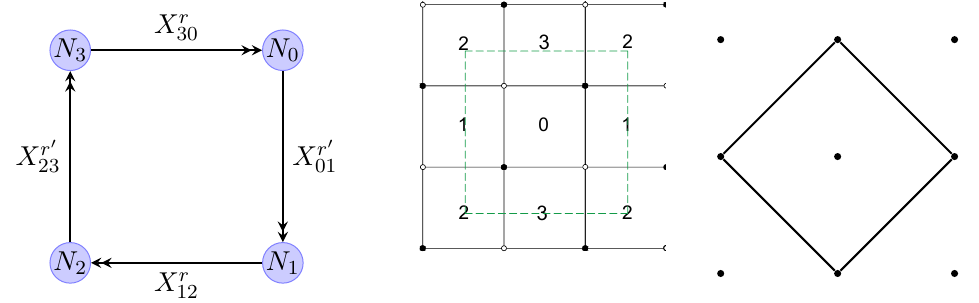
Figure 35. The quiver, the dimer and the toric diagram of the electric phase of the C = Z 0